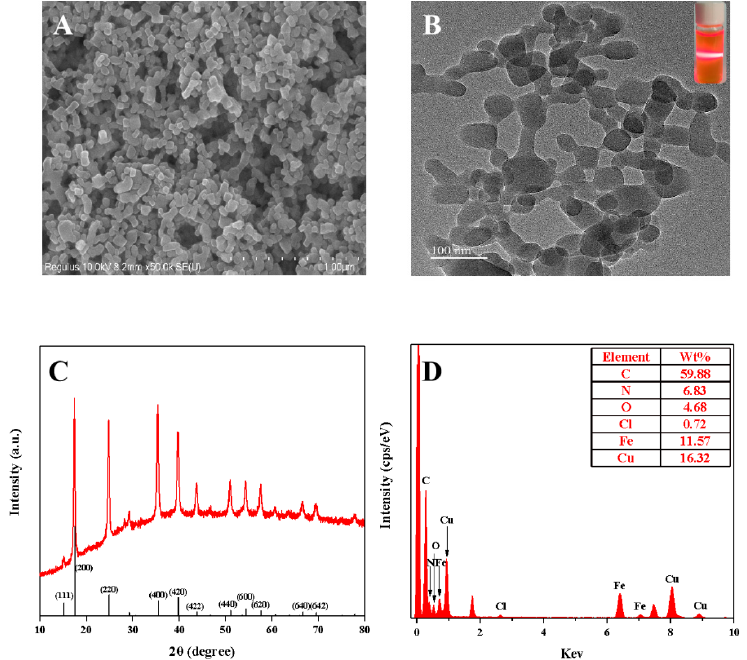
Figure 2. ( A ) SEM and TEM; ( B ) images of the copper hexacyanoferrate nanoparticles (inset: the image of the copper hexacyanoferrate nanoparticles under the irradiation of a red laser); ( C ) XRD plot of the copper hexacyanoferrate nanoparticles; ( D ) EDS plot of the copper hexacyanoferrate na-